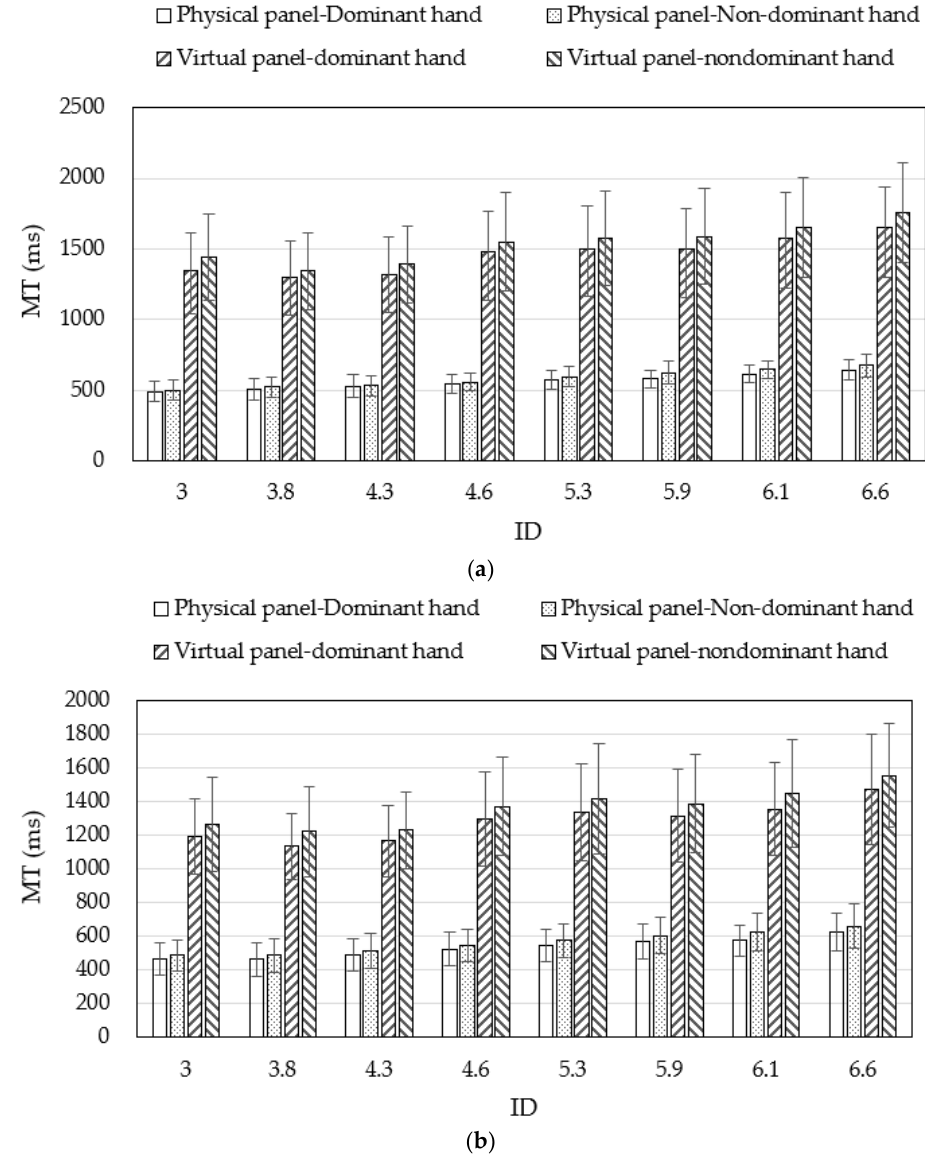
Figure 5. MT of female ( a ) and male ( b ) participants performing the horizontal pointing task.